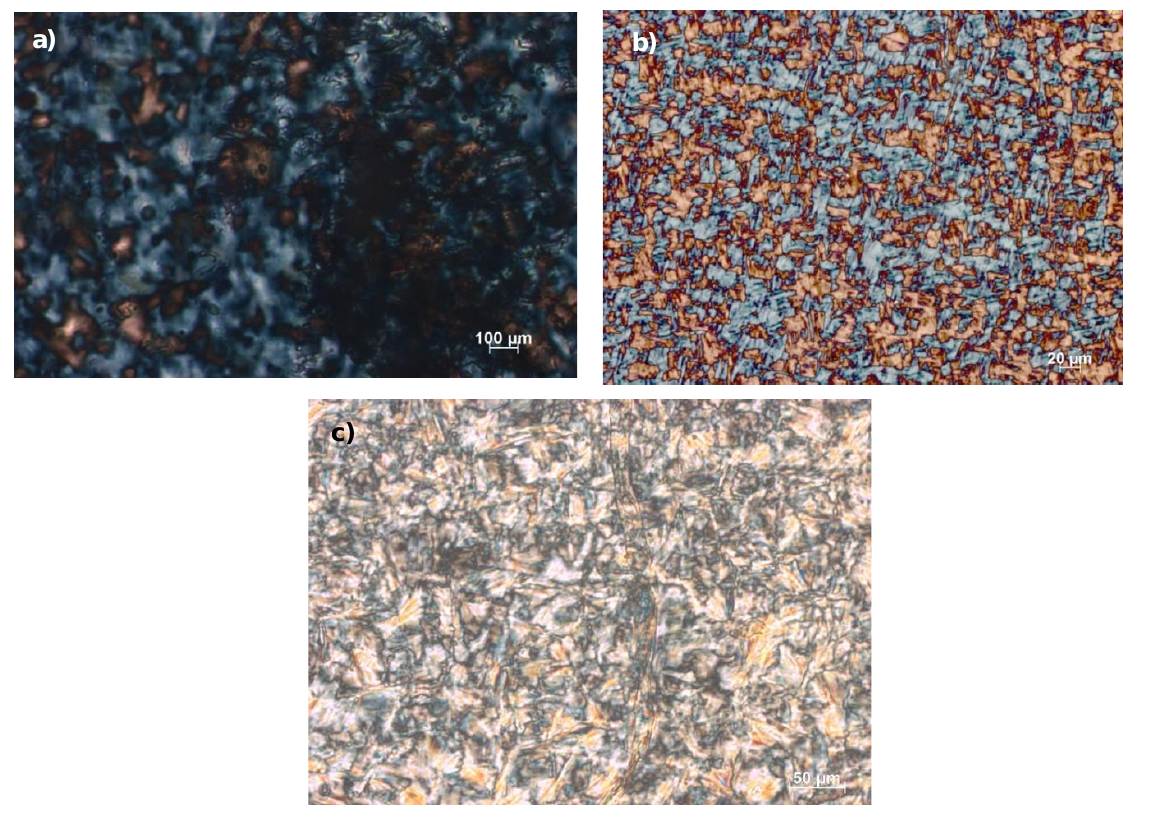
Figure 2. Optical textures of: ( a ) [Ph-Tri-(10) 2 ][OTf] at 69 ◦ C, ( b ) [Ph-Tri-(12) 2 ][OTf] at 77 ◦ C and ( c ) [Ph-Tri-(14) 2 ][OTf] at 57 ◦ C, obtained by polarized optical microscopy analysis under crossed polarizers showing the mesophase after the first transition from the isotropic liquid to the liquid crystalline phase upon cooling at 5 ◦ C min − 1 .